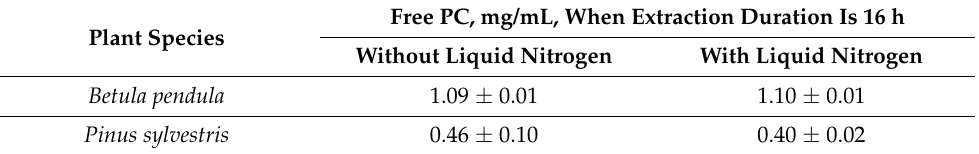
Table 2. The content of free PC in pollen extracts isolated by orbital shaking method. Plant